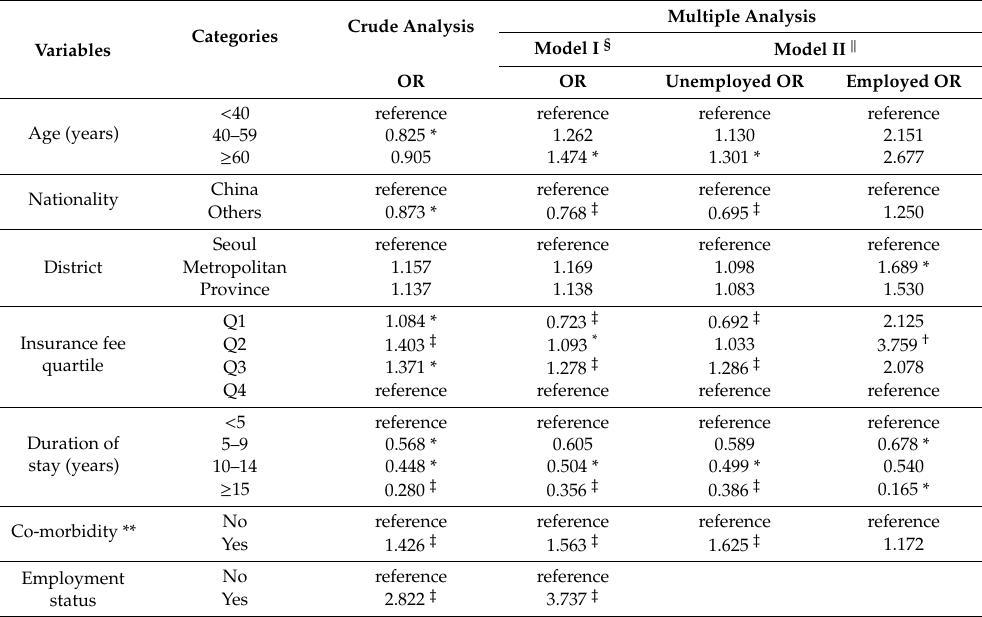
Table 3. The logistic regression analysis of health screening